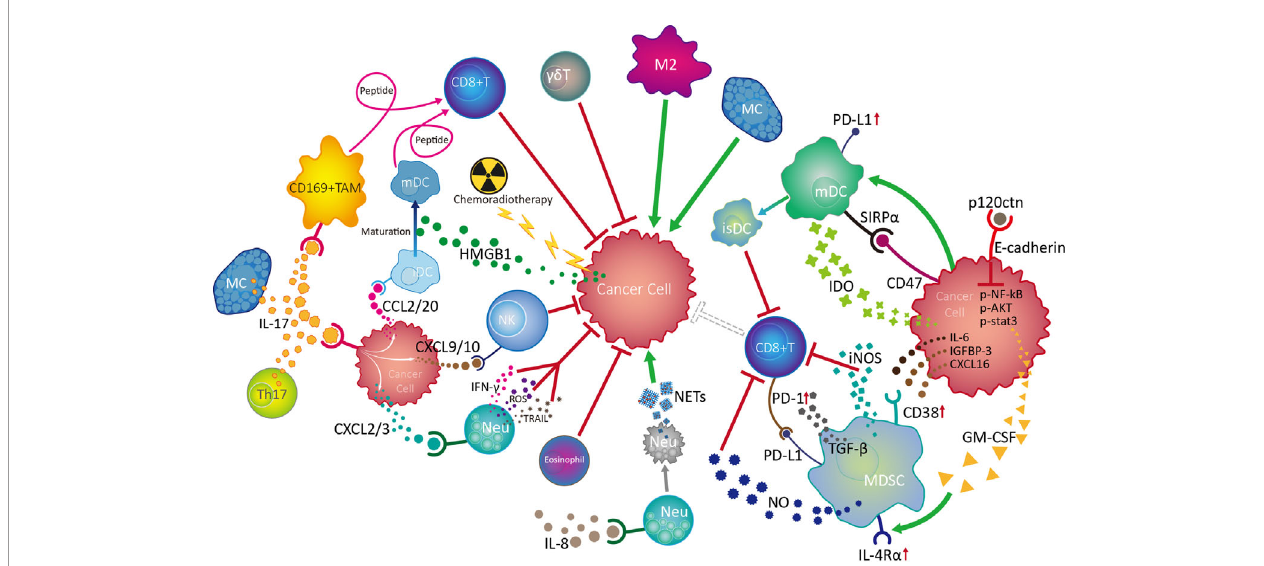
FIGURE 3 | Crosstalk and regulation of innate immune cells in the esophageal cancer tumor microenvironment. Among the multiple innate immune cells involved in esophageal cancer progression, NK and gd T cells are active in the front line of anti-tumor defences with their powerful cytotoxicity. Mature dendritic cells (mDC) play vital roles in antitumour responses by boosting the function of CD8+ effector T cells, while chemoradiotherapy can promote DC maturity by increasing HMGB1 levels in the tumor microenvironment (TME). IL-17 derived from Th17 cells and MCs can activate CD169+ tumor in fi ltrating macrophages (TAMs) and effector CD8+ T cells, as well as recruit NK cells, CD1a+ immature DCs (iDC) and neutrophils (Neu) into the TME by stimulating cancer cells to release various chemokines, thereby exerting antitumour effects. Although the mechanism is unknown, eosinophils are also involved in the anti-tumor process. On the contrary, neutrophils can also promote tumor development by inhibiting NK cell function in response to IL-8, as well as by forming NETs after tumor-induced apoptosis. MCs can promote tumor cell growth through the TK1/mitogenic kinin pathway. Importantly, tumor cells can escape from innate immune surveillance by promoting TAM progression to a suppressive M2 phenotype, which inhibits CD8 + T cell function by transforming DCs into an immunosuppressive phenotype (isDC) and recruiting myeloid-derived suppressor cells to inhibit the cytotoxic effects of CD8 + T and NK